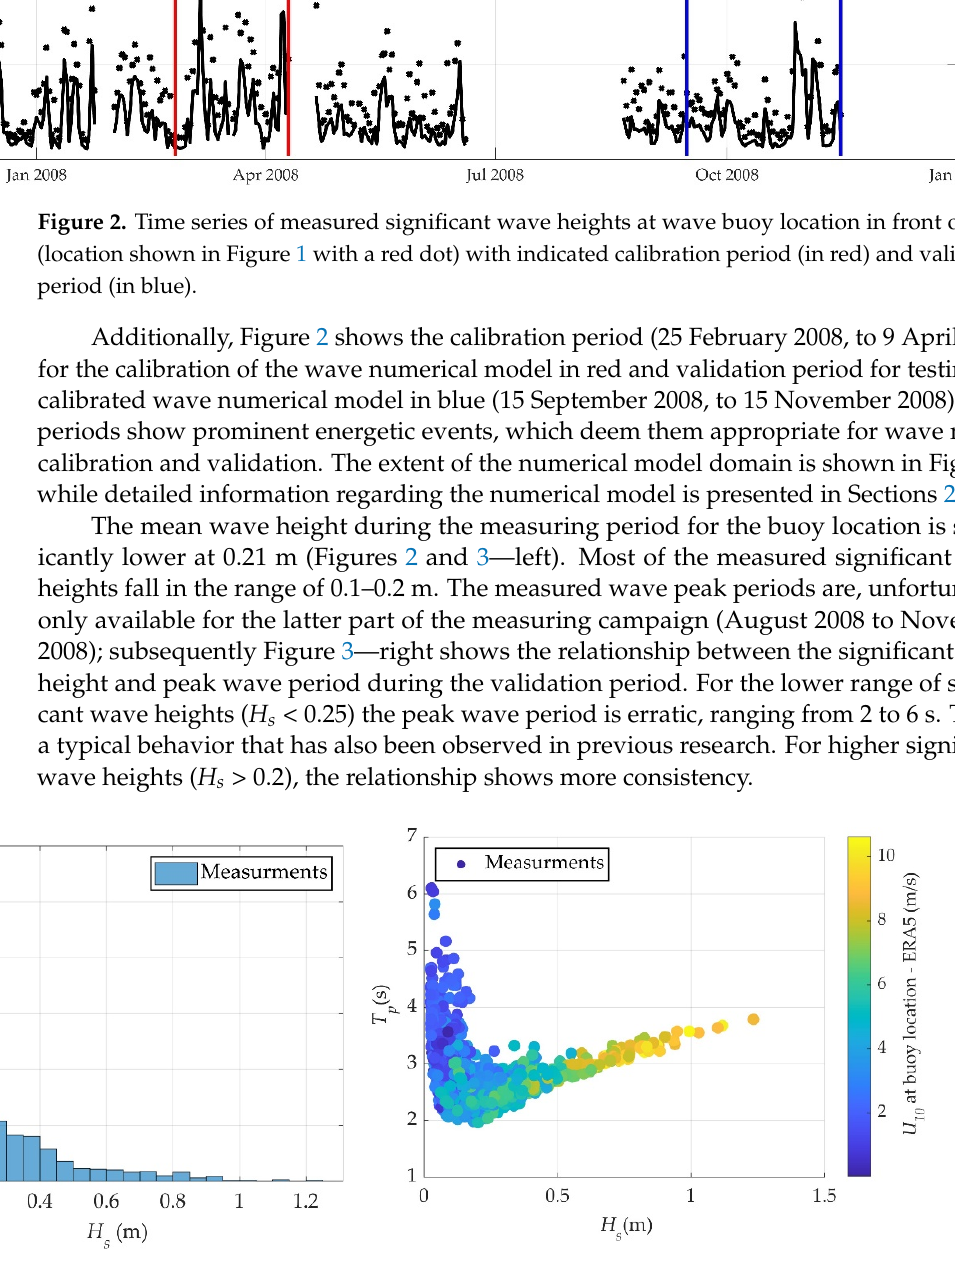
Figure 3. ( left ) Histogram of measured wave parameters at wave buoy location in front of Split (Figure 3) for the whole measuring period from November 2007 to November 2008 (Figure 2)—bin size of 0.05 m; ( right ) Scatter diagram between the measured significant wave heights and peak wave periods for the validation period with ERA5 simulated wind magnitudes at the buoy location as